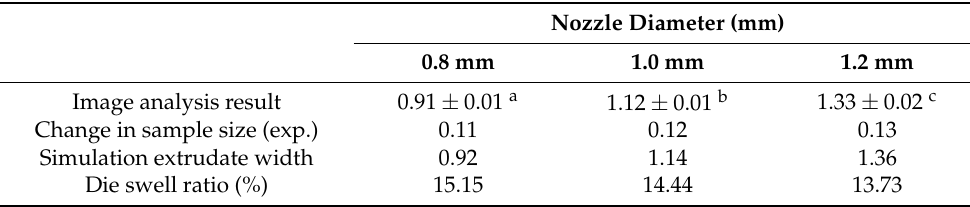
Table 4. Swell ratio of rice paste as influenced by the nozzle diameter.